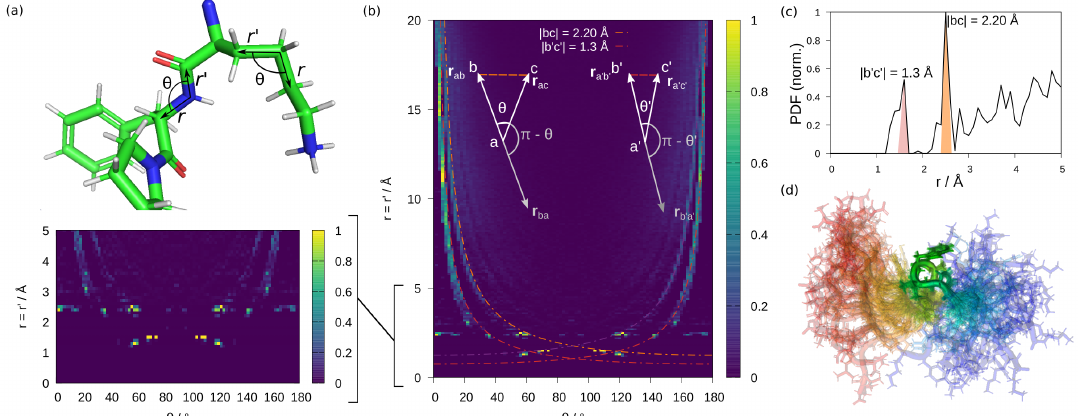
Figure 2. Model PADF plot for a disordered protein in solution. ( a ) At short distances, the PADF plot contains sharp peaks due to the strong geometric constraints imposed by covalent